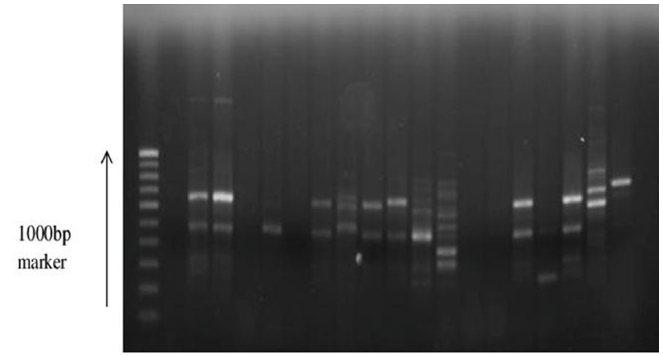
Fig. 2. Gel image with ERIC banding